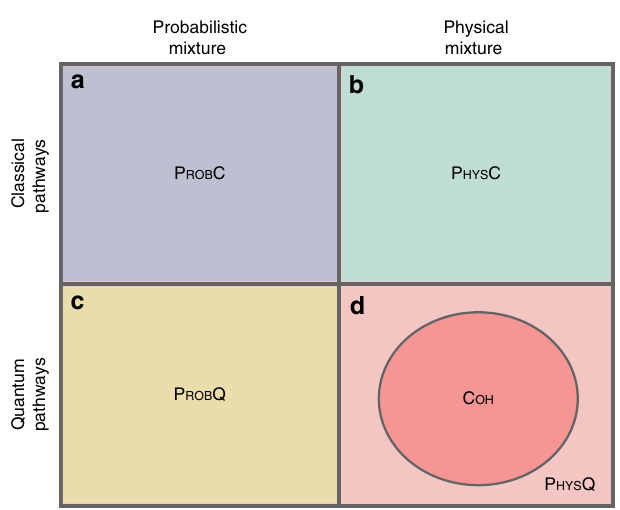
Figure 3 | Classification of mixtures of causal relations between two quantum systems. One can distinguish whether the common-cause and cause-effect pathways are effectively classical or whether they are quantum, and whether they are combined in a probabilistic or a physical mixture. This gives rise to four categories of interest: ( a ) a probabilistic mixture that is classical on both pathways (P ROB C), ( b ) a physical mixture that is classical on both pathways (P HYS C), ( c ) a probabilistic mixture that is quantum on both pathways (P ROB Q) and ( d ) a physical mixture that is quantum on both pathways (P HYS Q). We leave aside cases wherein only one pathway is quantum. The focus of this paper is the class C OH , which exhibits the quantum Berkson effect and therefore describes quantum-coherent mixtures of common-cause and cause-effect relations between A and B